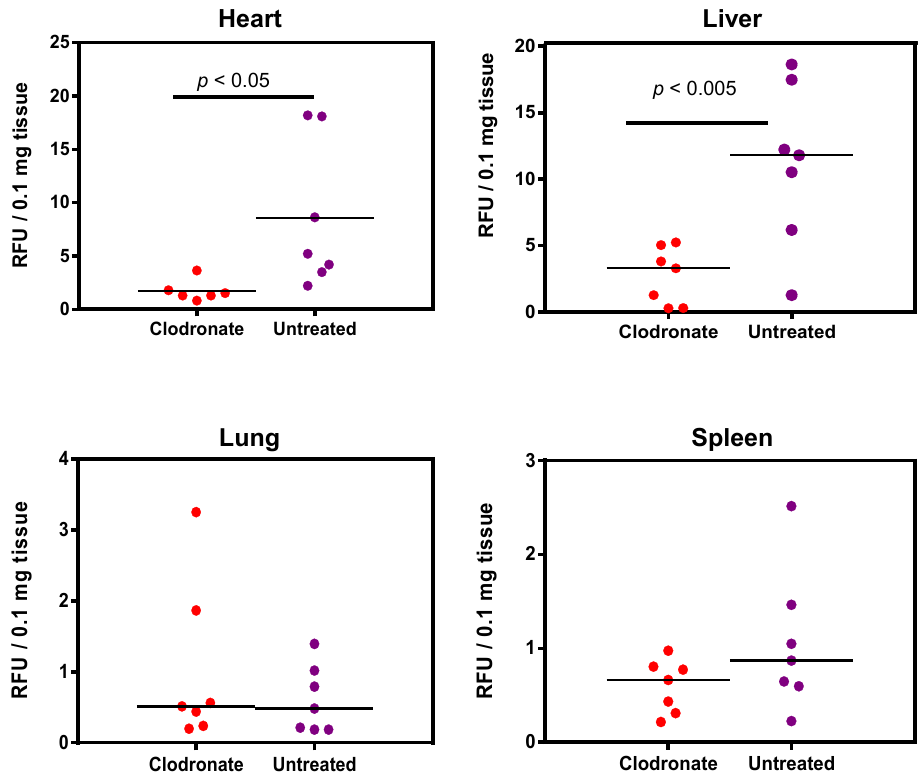
Figure 4. Quantification of alkaline phosphatase activity following systemic administration of 1 × 10 11 vg of an AAV6 vector expressing human placental alkaline phosphatase (hPLAP) with and without prior intravenous administration of clodronate. In the heart ( p < 0.05) and liver ( p < 0.005), a statistically significant difference could be observed in clodronate-treated and untreated mice, with untreated mice possessing on average ~4 fold more alkaline phosphatase activity. No significant difference could be observed in the levels of alkaline phosphatase activity in mouse lung and spleen.